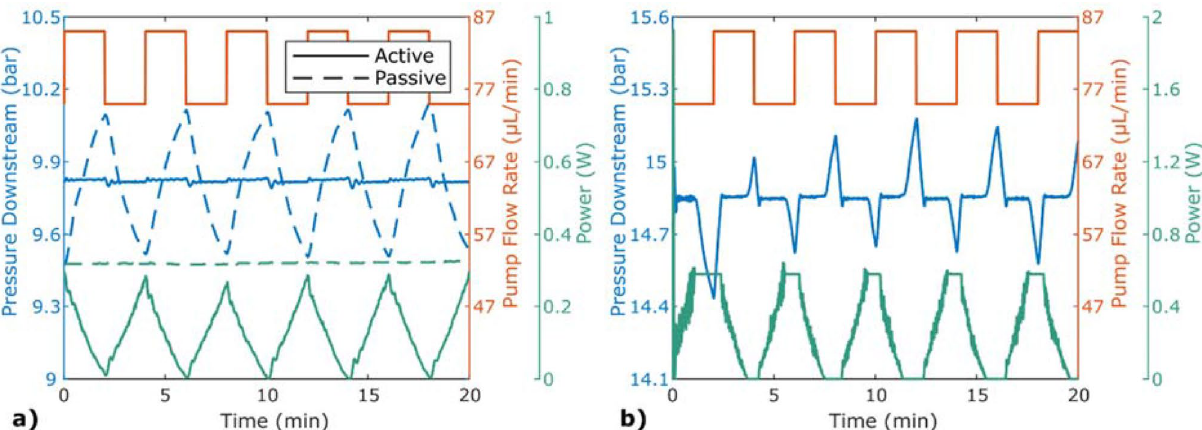
Figure 3. Pressure stabilisation with the set flow rate altering between 75 and 85 μL/min every second minute. The experiments were performed using an ISCO pump. ( a ) Active stabilisation (solid lines) was performed by PID-regulating the heater power of the stabiliser using an external pressure sensor downstream of the stabiliser as a feedback sensor. Passive stabilisation (dashed lines) was performed using constant power. During the passive run, the pump volume started with 15 mL and during the active run, the pump volume started at 9 ml. ( b ) The experiment was repeated with a smaller initial pump volume of 4 mL, to show that if the buffer capacity is too small, the stabilisation will not last